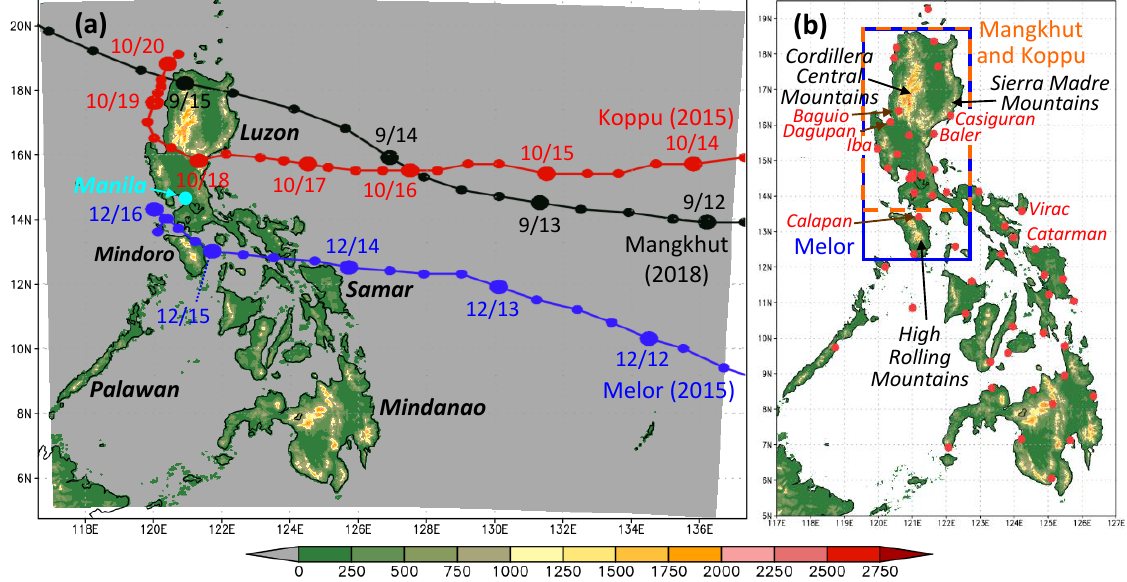
Figure 1. ( a ) The geography and topography (m, color) of the Philippines, model domain (shaded region), and the Joint Typhoon Warning Center (JTWC) best tracks of the three typhoons in this